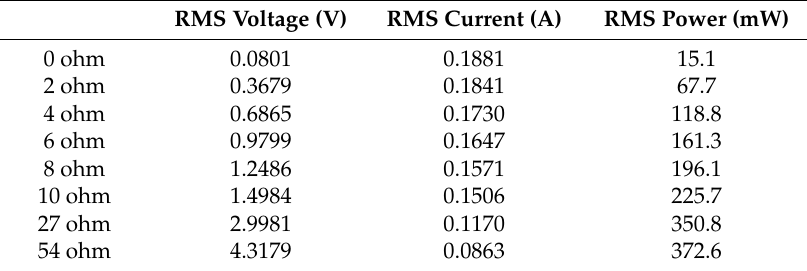
Table 7. RMS power output.